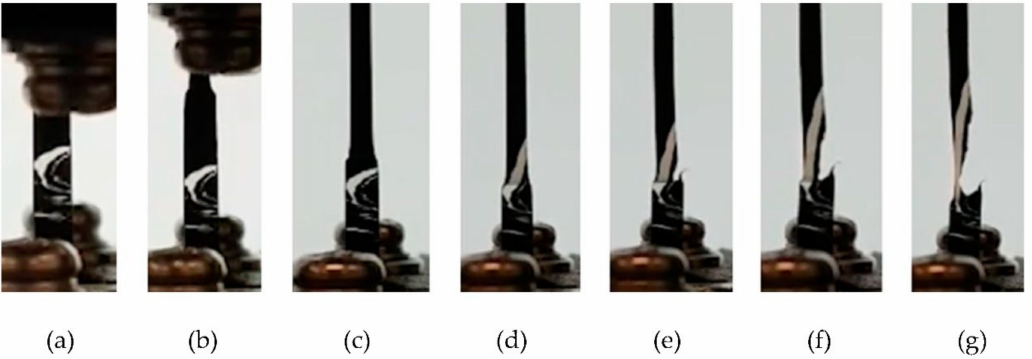
Figure 21. Frame-by-frame photographs showing the progression of windows’ deformation to tear